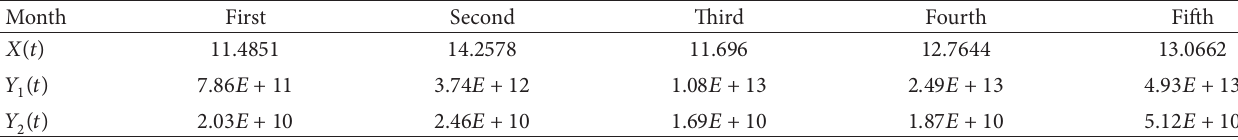
Table 5: The input and outputs center of gravity for DMU 4 .